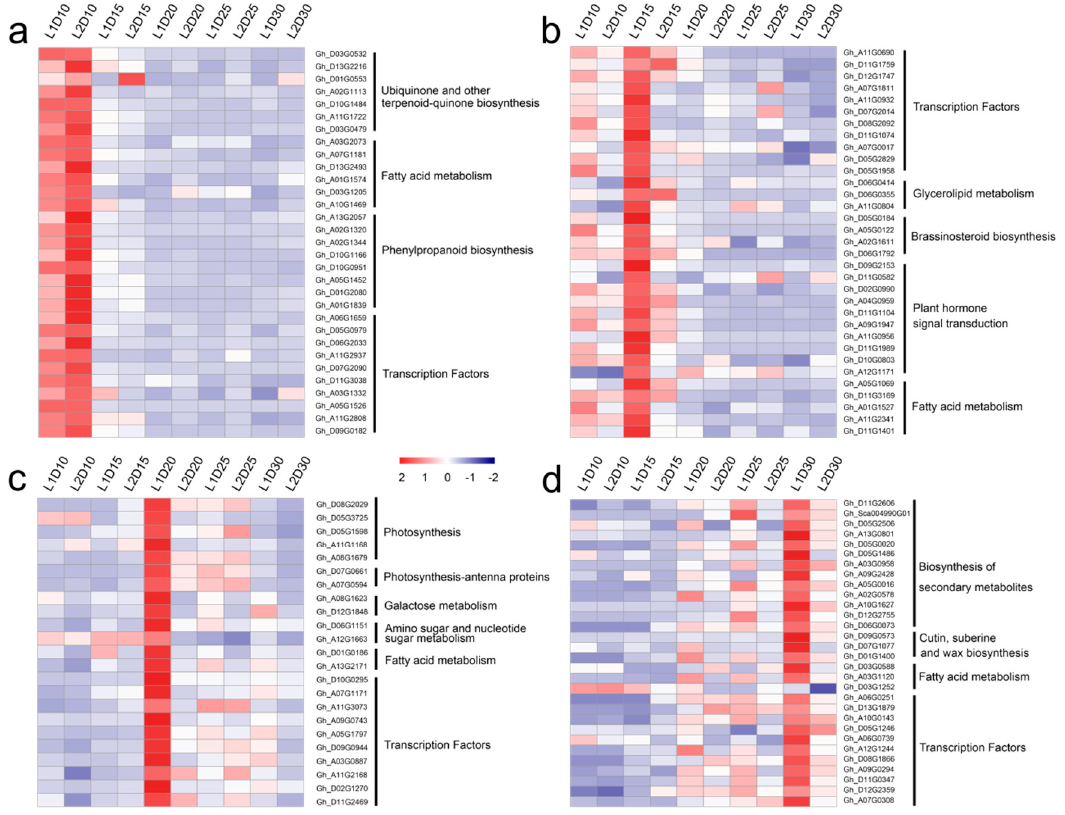
Figure 7. Heatmap comparison DEGs associated with fiber developmental stages. ( a ), ( b ), ( c ), and ( d ) show the DEGs associated to the overrepresented functional categories and transcription factors at 10, 15, 20, and 30 days post-anthesis (DPA), respectively.